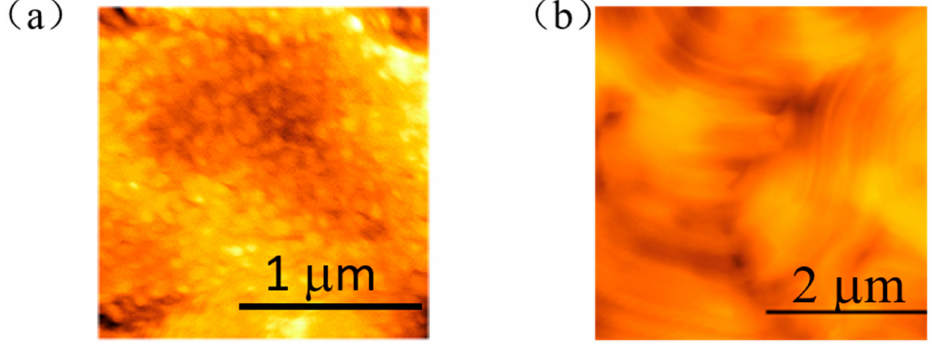
Figure 2. Top-surface atomic force microscopy (AFM) images of the deposited ( a ) PMLG and ( b ) PBLG film,